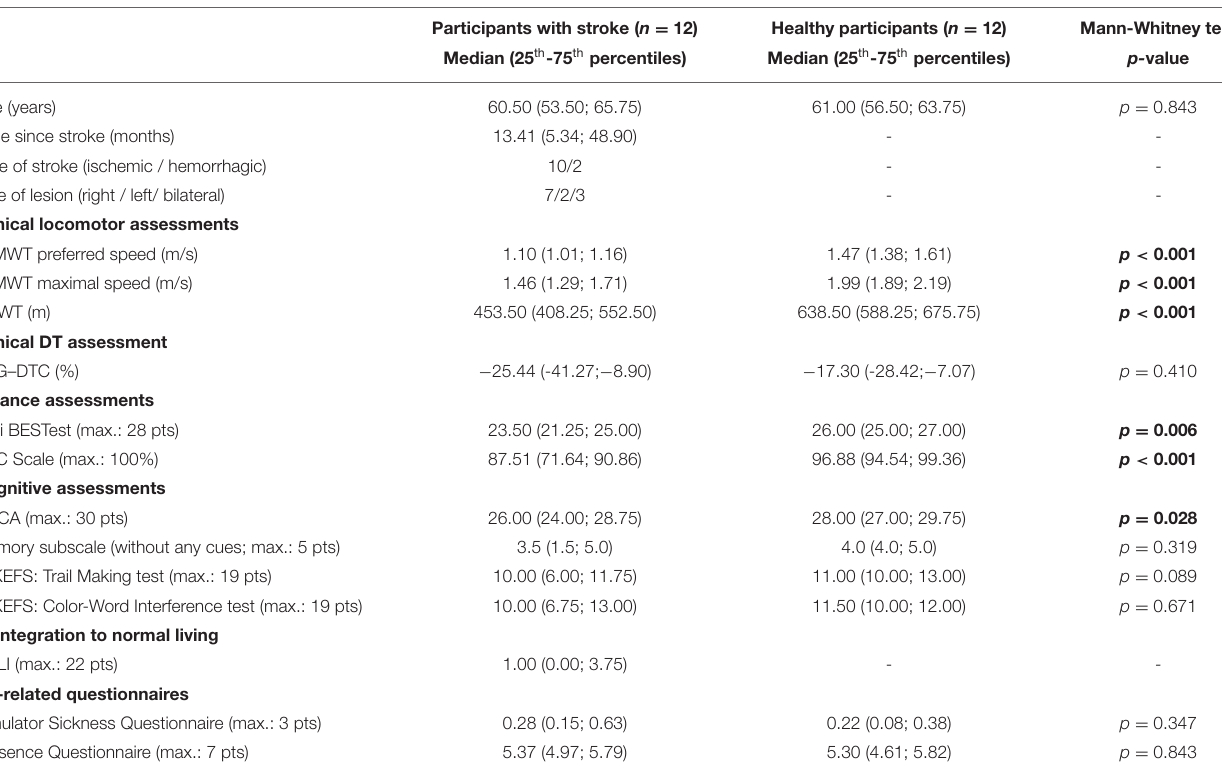
TABLE 1 | Participant’s